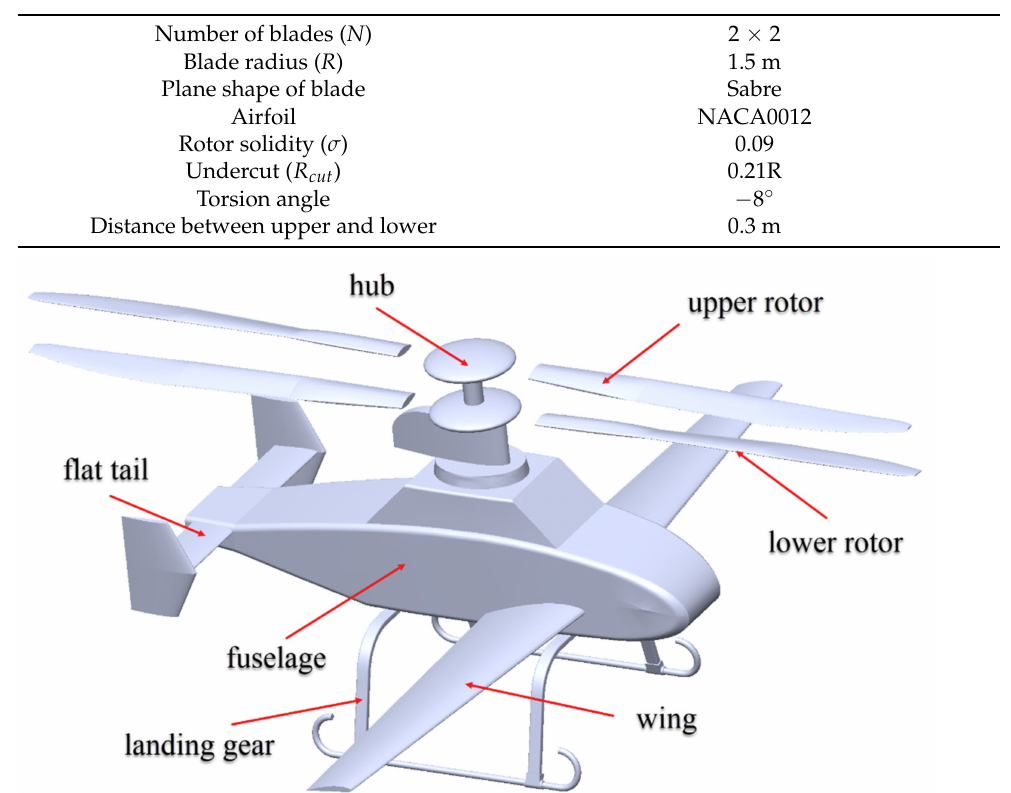
Table 2. Detailed parameters of compound coaxial helicopter rotor.